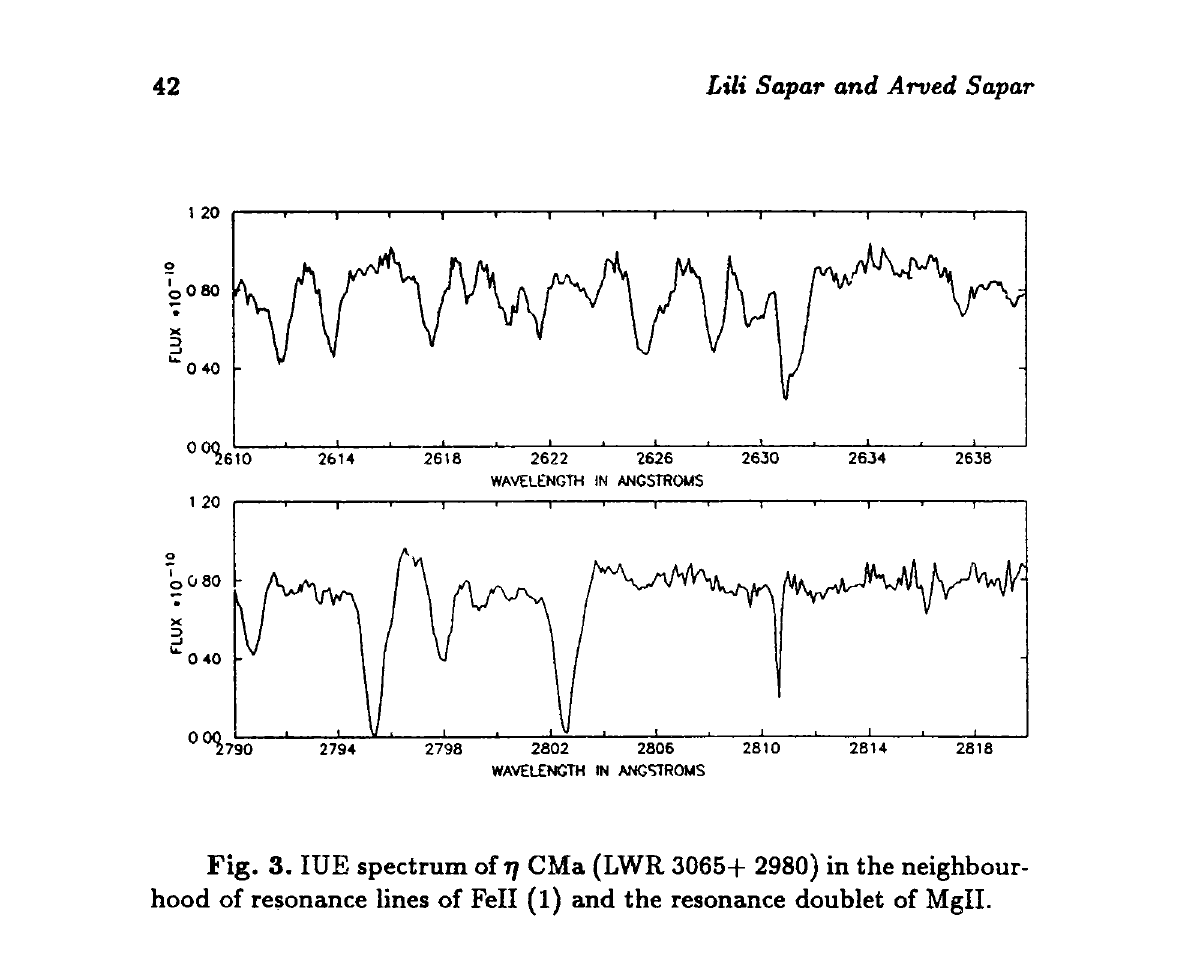
Fig. 3. IUE spectrum of 77 CMa (LWR 3065+ 2980) in the neighbour- hood of resonance lines of Fell (l) and the resonance doublet of